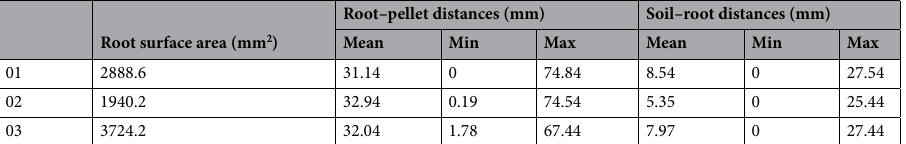
Table 1. Image analysis measurements of root surface area, average root distance from pellet and average soil distance from root in the sector selected for modelling. The maximum and minimum are also included to demonstrate the variation in the